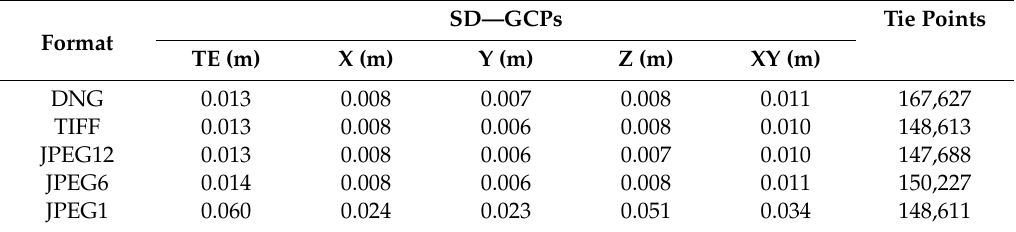
Table 5. Evaluation of the accuracy on GCPs and number of tie points—Test site 3.